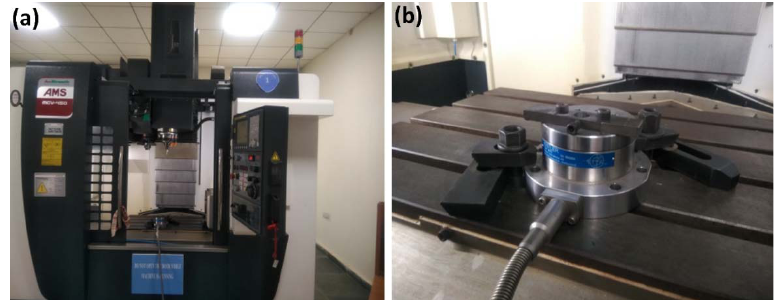
Figure 4. ( a ) CNC milling machine, ( b ) Tool Dynamometer in CNC milling m/c. Table 4. Input ‐ machining parameters with their levels. Materials 2022 , 15 , x FOR PEER REVIEW